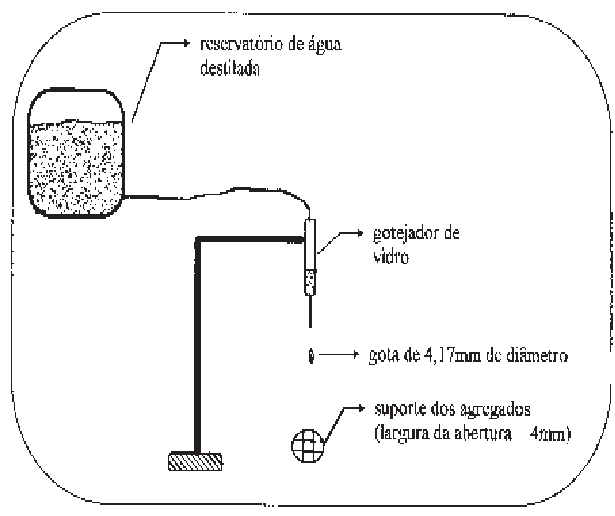
Figura 1. Esquema do gotejador utilizado no teste de resistência ao impacto de gotas (fora de